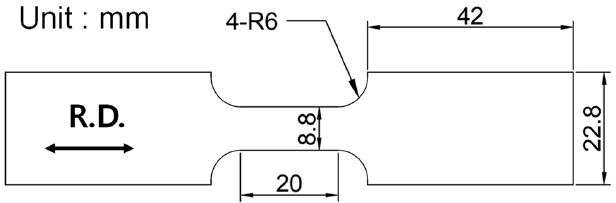
Figure 1. The schematic of the tensile test specimen.